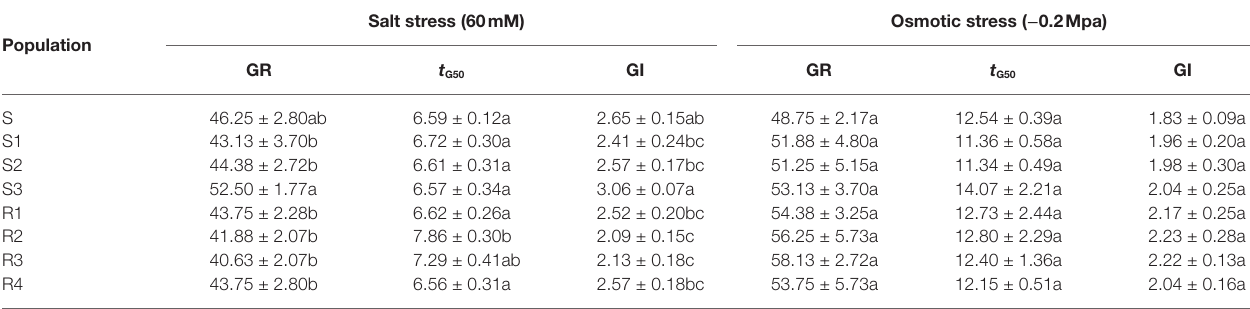
TABLE 4 | Germination characteristics of seven different populations under salt and osmotic stress.